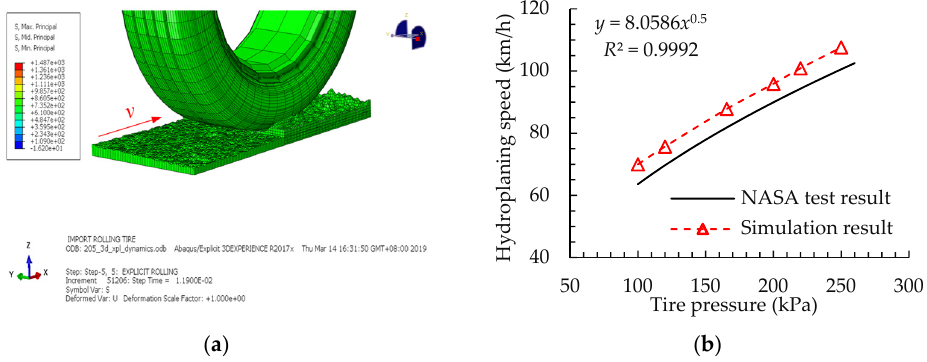
Figure 6. Validation of tire hydroplaning FE model: ( a ) simulation of tire hydroplaning process; ( b ) critical hydroplaning speed of the tire.